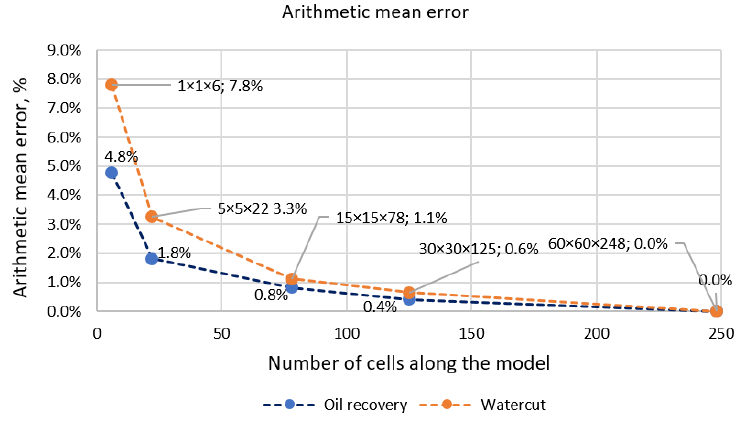
Figure 14. Analysis of the effect of mesh size reduction on the gain in accuracy of the calculation.